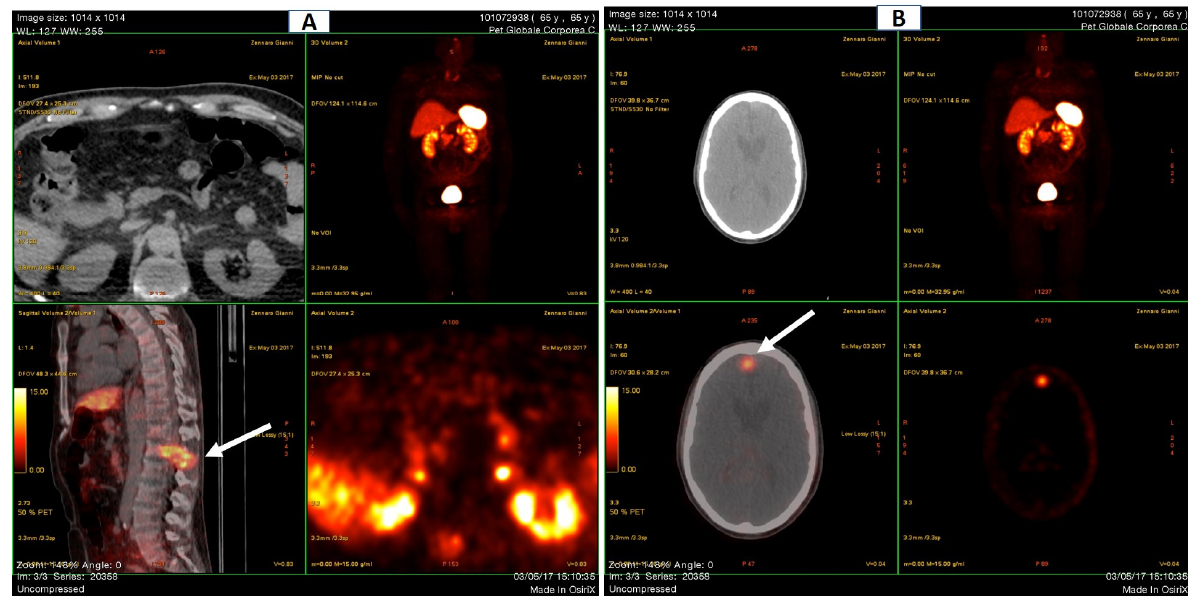
Figure 4. Global PET (Ga68-DOTATOC). ( A ) Spine. The white arrow indicates hypercaptation at T12/L1. ( B ) Skull. The white arrow indicates a focal area of increased uptake (max. axial diameter 13 mm). The patient was diagnosed with oncogenic osteomalacia, treated with phosphorous supplement (1000 mg/day), calcitriol 0.50 mcg/day and opioid painkillers, and thereafter transferred to a Surgical Unit. The timeline of the diagnostic process is schematized in Figure 5.